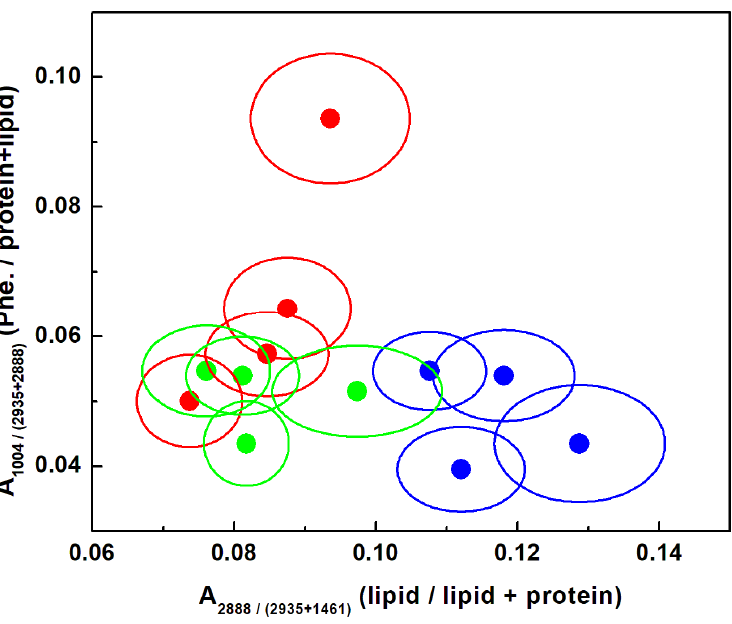
Figure 4. Statistical representation, using 1-sigma ellipsoids, of ratios of phenylalanine content to combined protein and lipid content (i.e., ratios of peak areas at 1004 cm − 1 to corresponding sums obtained by adding peak areas at the 2935 cm − 1 and 2888 cm − 1 ) and corresponding ratios of lipid to overall protein content (i.e., ratios of peak areas at 2888 cm − 1 to corresponding sums obtained by adding peak areas at 2935 cm − 1 and 1461 cm − 1 ). The solid circle defines the average over 22,500 spectra for each biomarker. A red color code was used for the malign GBM sample, blue for the NDGA-treated GBM sample treated with 100 μ M for 24 h, and green for the NDGA-treated GBM sample treated with 250 μ M for 4 h.